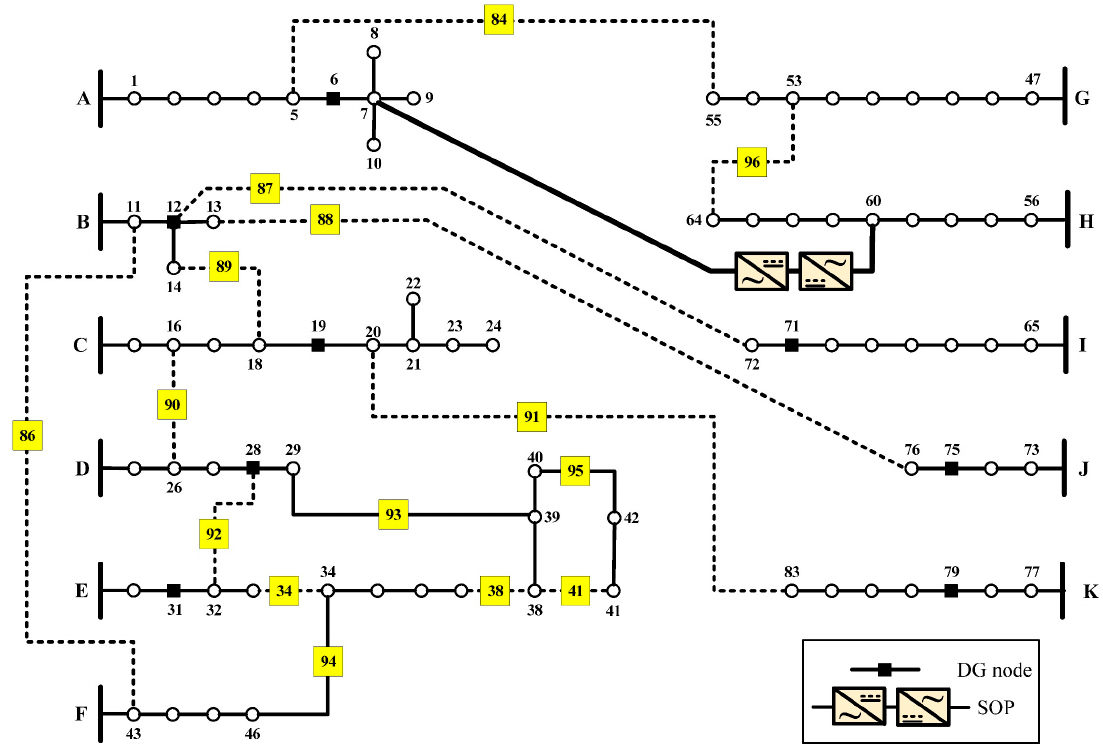
Figure A2. 83-node distribution system after NR, SOPs, and DGs allocation with SOPs internal losses considered: scenario